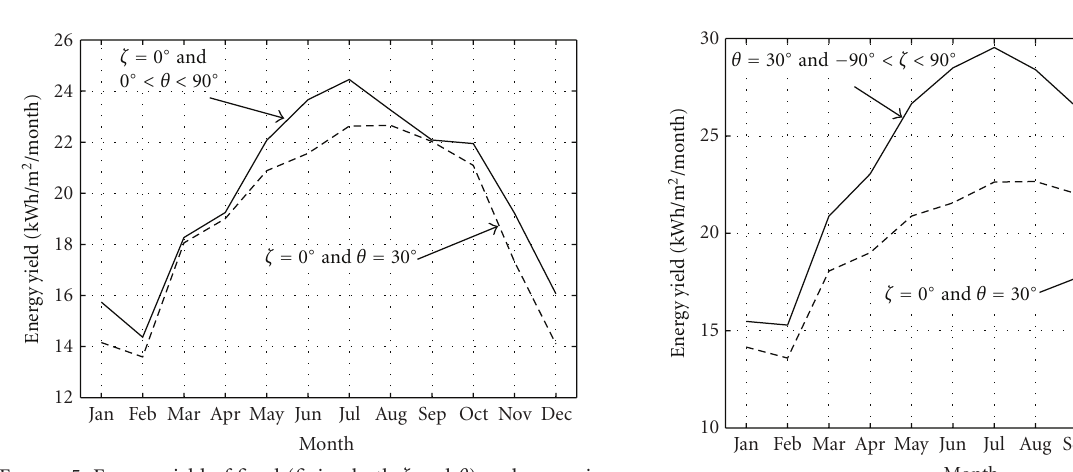
Figure 5: Energy yield of fixed (fixing both ζ and θ ) and one-axis (fixing ζ and varying θ ) PV systems for each month. The maximum energy yield occurs in July for both lines. The gain of such tracking over the fixed one is 5.87%.